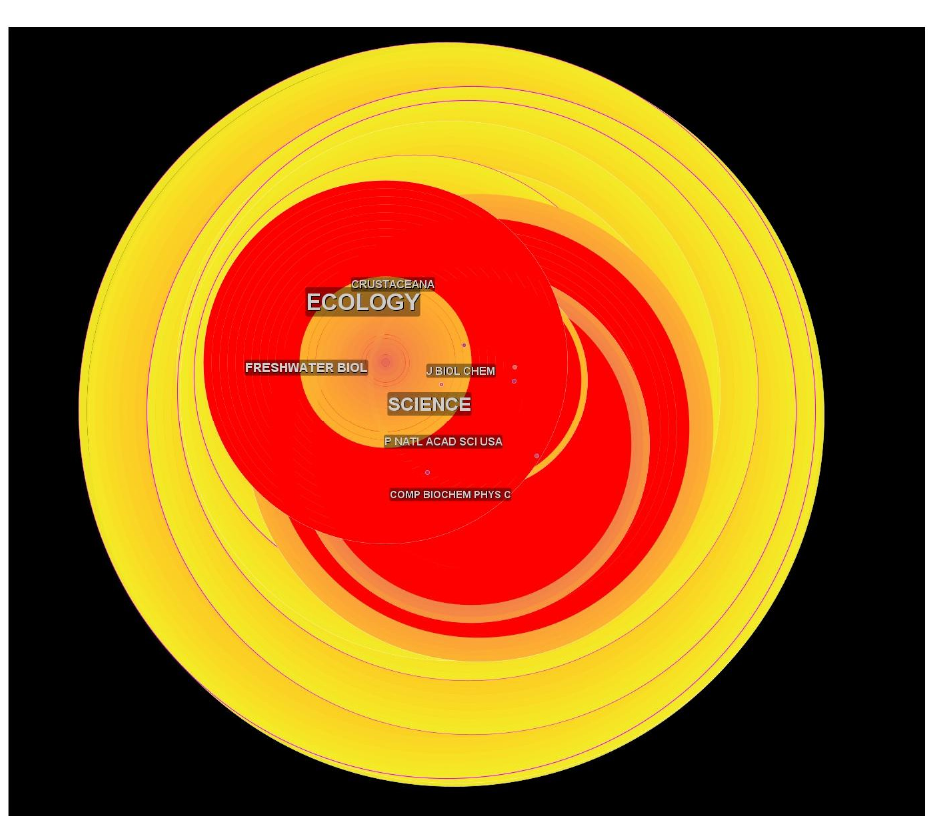
Figure 5. Journal co-citation analysis, where only journals with centrality scores greater than 0.1 are included. Table 7. Top 10 publications identified by the co-citation analysis, ranked according to Sigma scores.